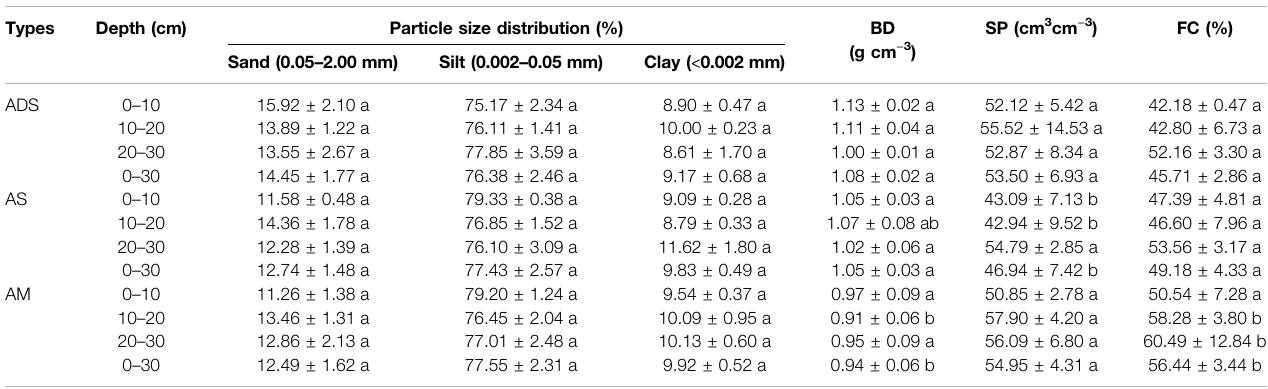
TABLE 3 | Physical properties of soil under three vegetation types.